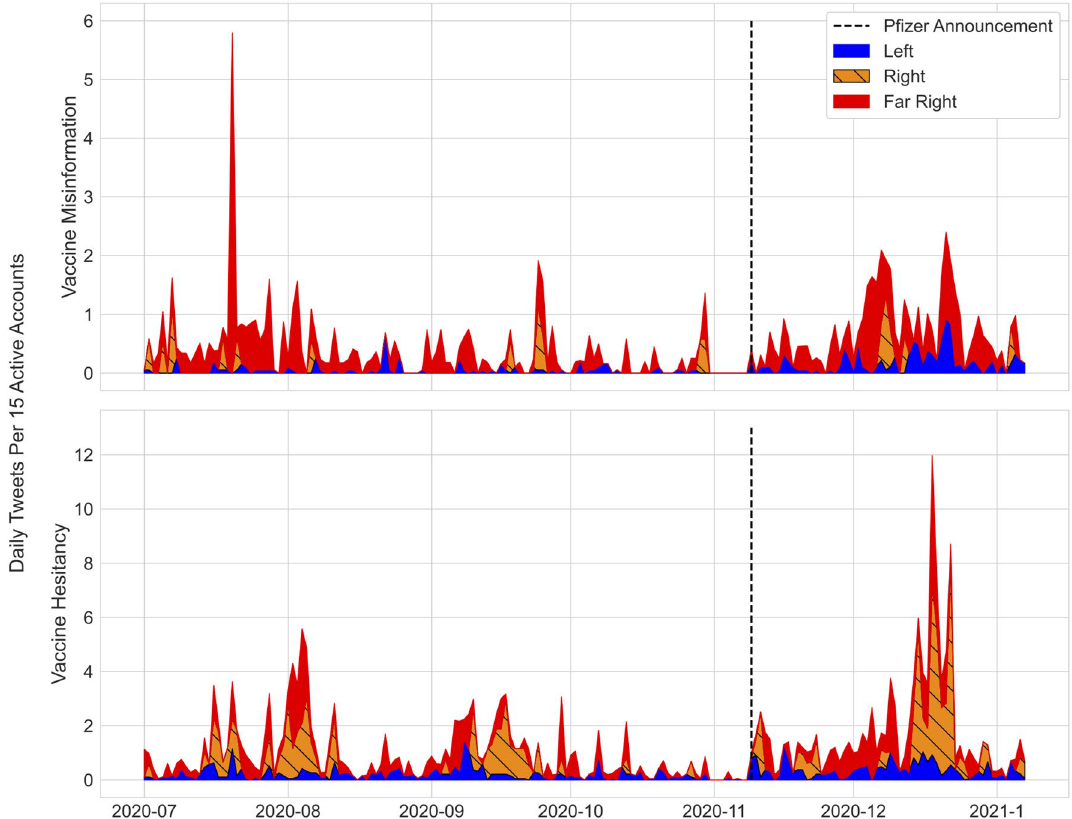
Figure 5. Daily tweets by cluster containing phrases associated with vaccine misinformation (Top) or vaccine hesitancy (Bottom). Vertical axis corresponds to daily tweets per 15 active accounts. Tweets containing vaccine misinformation phrases are primarily confined to the Far Right (red). Tweets containing vaccine hesitancy phrases occur sporadically in both the Far Right (red) and the Right (orange), at a higher volume than in the Left (blue). Vertical line corresponds to announcement of Pfizer phase three trial results on November 9, 2020.